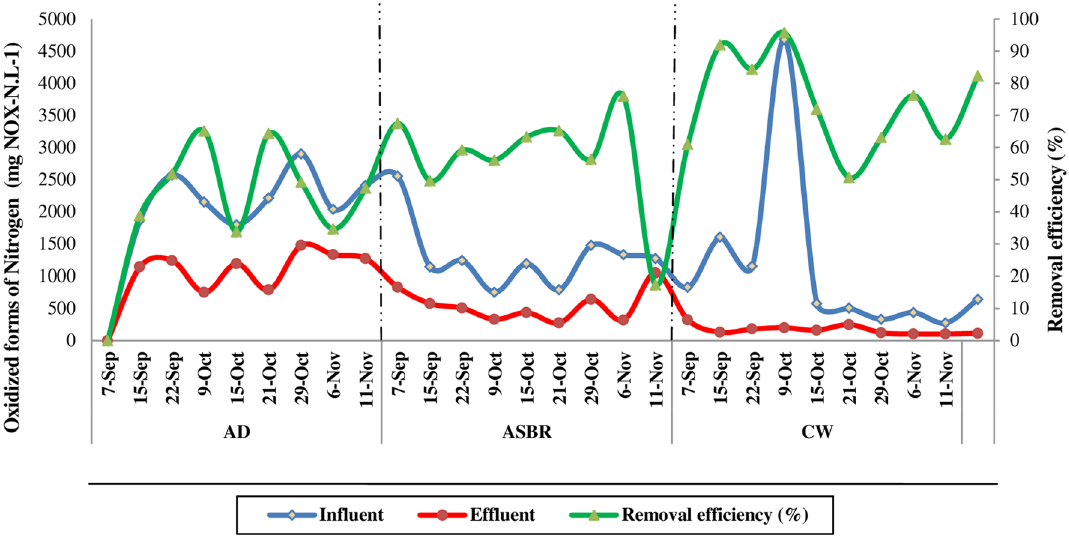
Fig. 8 Variation in NO X –N removal efficiency (in percent) and average NO X –N concentration in the influent and effluent of each